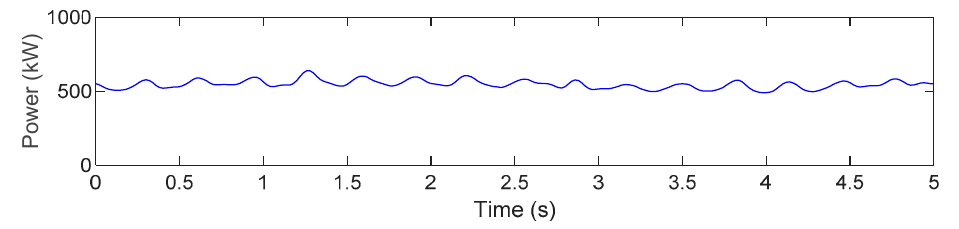
Figure 3. Active power of the SAS 630 kW motor during normal operation with filled ball mill.